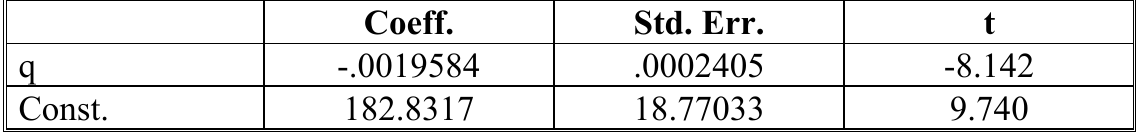
Results of estimating a constrained linear demand function for tourists from non-African countries Coeff. Std. Err.